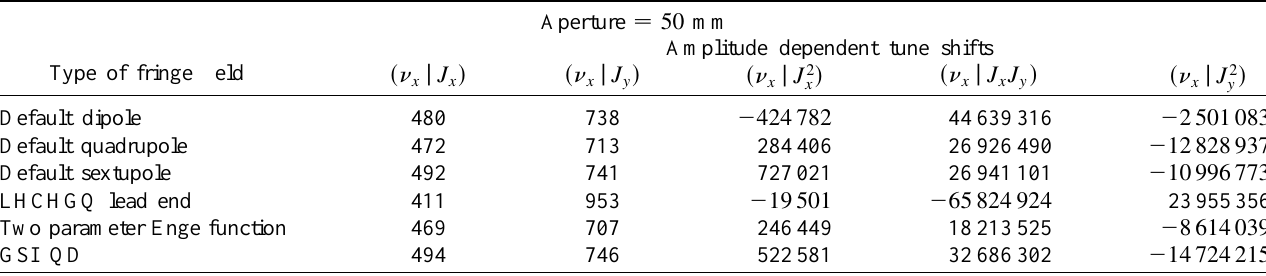
TABLE V. A few amplitude dependent tune shifts for the 50 mm aperture case. All six of the studied fringe field fall-off shapes are included.